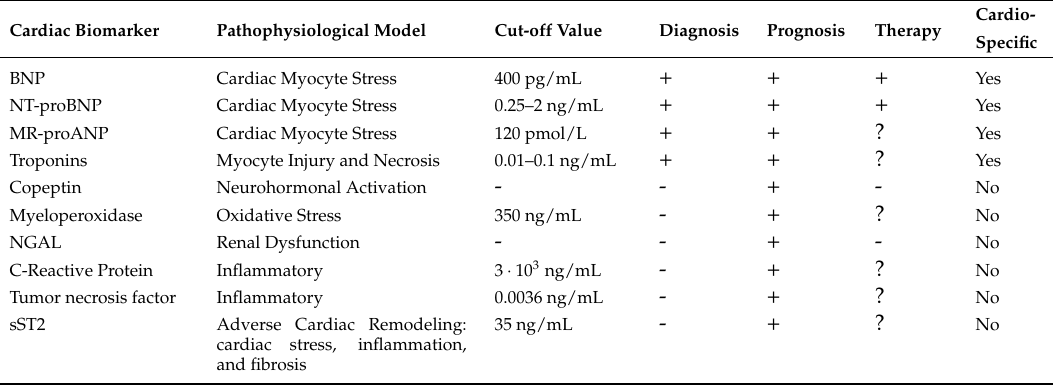
Table 1. Comparison of promising cardiac